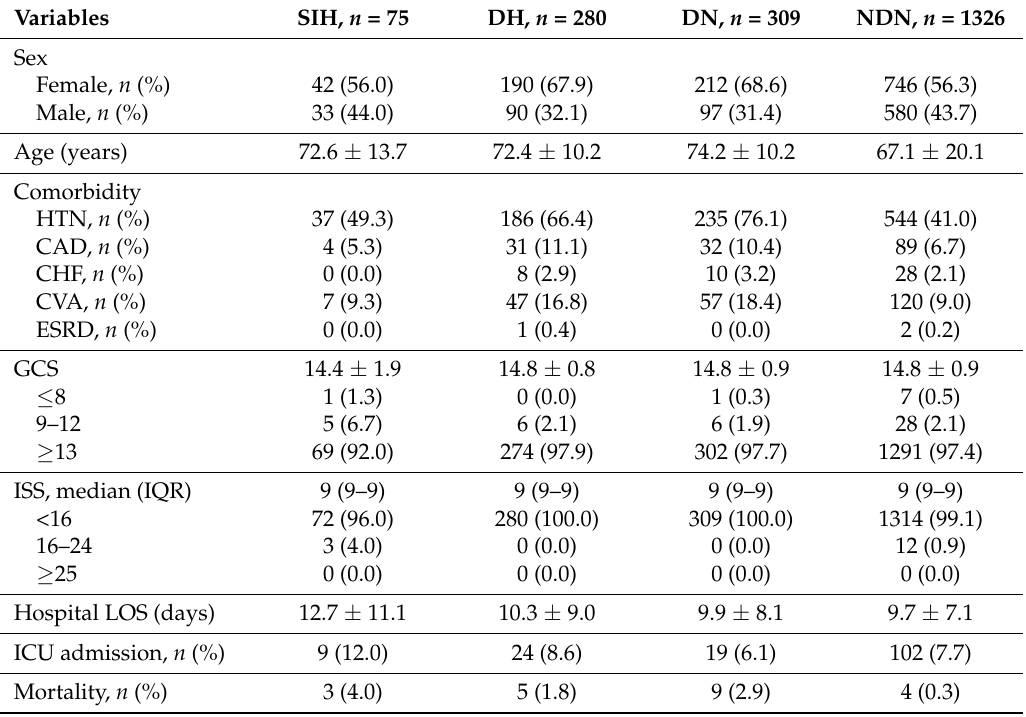
Table 1. Characteristics and outcomes of the patient